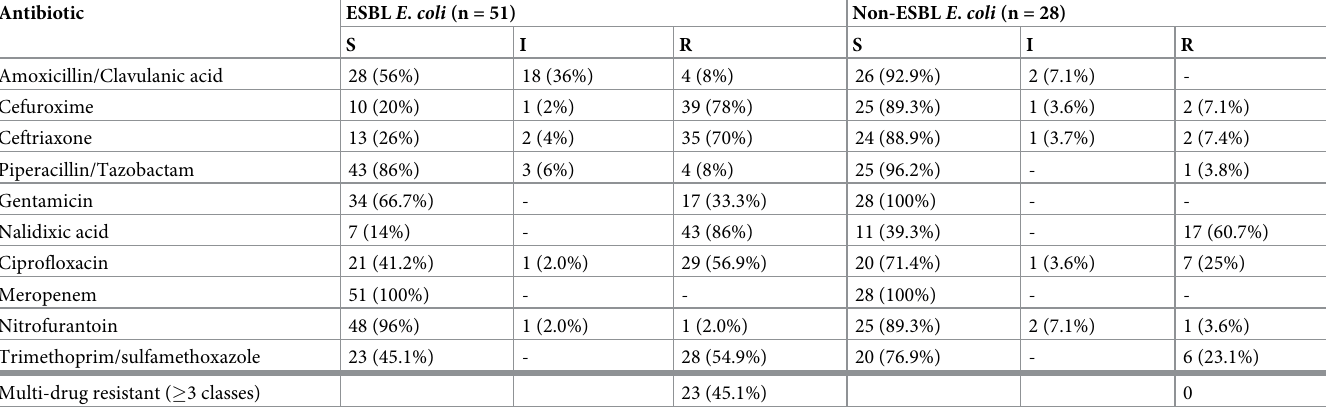
Table 3. Antimicrobial resistance patterns of E . coli isolates by ESBL positivity. Antibiotic ESBL E . coli (n = 51) Non-ESBL E . coli (n =